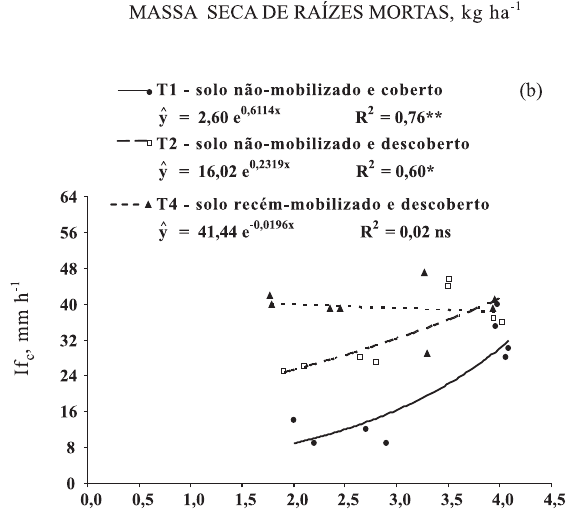
Na figura 5 são apresentados os resultados da